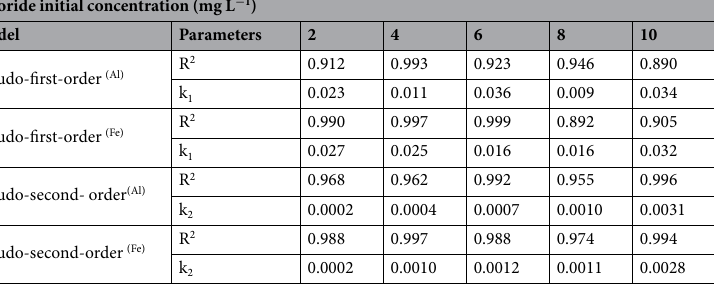
Table 2. Kinetic parameters for F adsorption onto Al 2 O 3 and Fe 3 O 4 NPs-PUF at different initial F